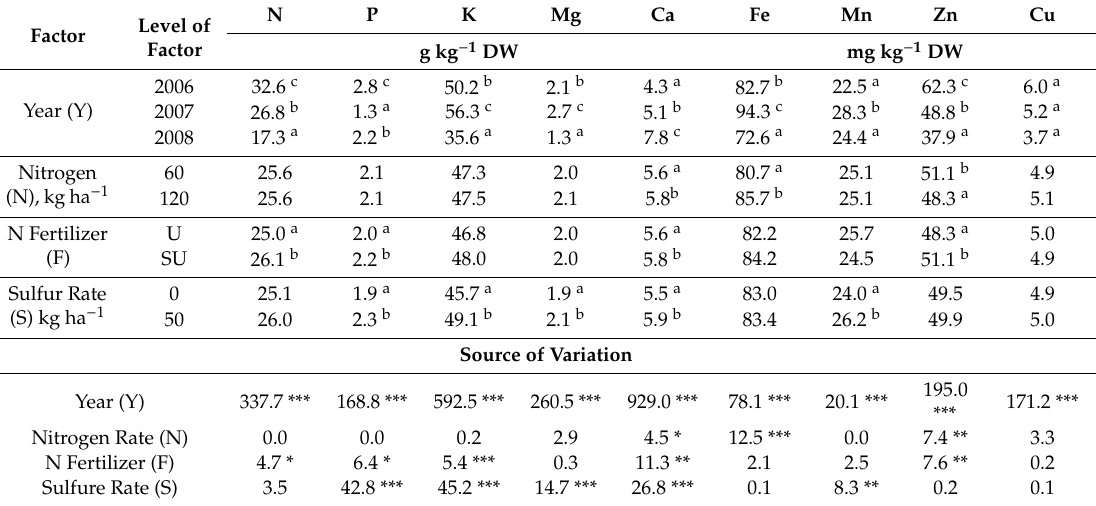
Table 5. Nutrient content in the potato stems at the onset of tuberization (BBCH 39 /